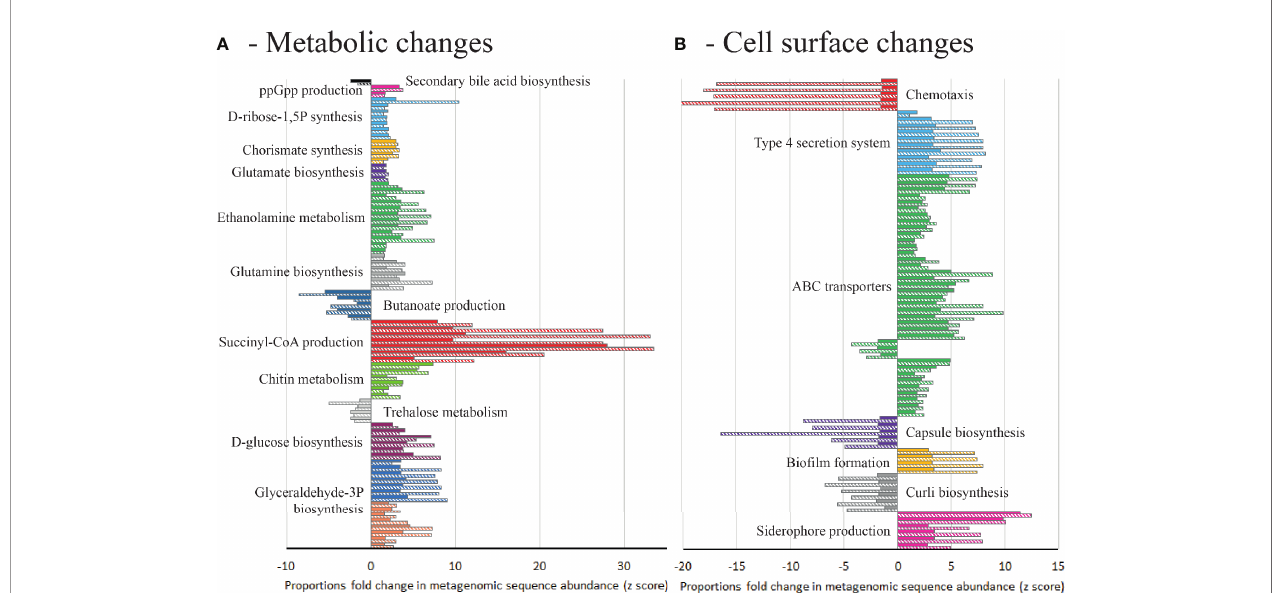
FIGURE 6 | Differential abundance analysis (fold-change) of metabolic pathways in model T compared to models G (solid bars) and S (hatched bars) at day 38, based on metagenomics analysis. Abundance bars highlight the KEGG metabolic pathways (A) or KEGG cell surface components (B) that are signi fi cantly ( p =<0.05) more abundant (>-1.5 fold-change) or less abundant (>1.5 fold-change) in model T. Pathways or components were only included where 80% of the genetic elements in that pathway/component showed an increased or decreased abundance from technical replicates of model T compared to both models G and S ( Supplementary Table 4